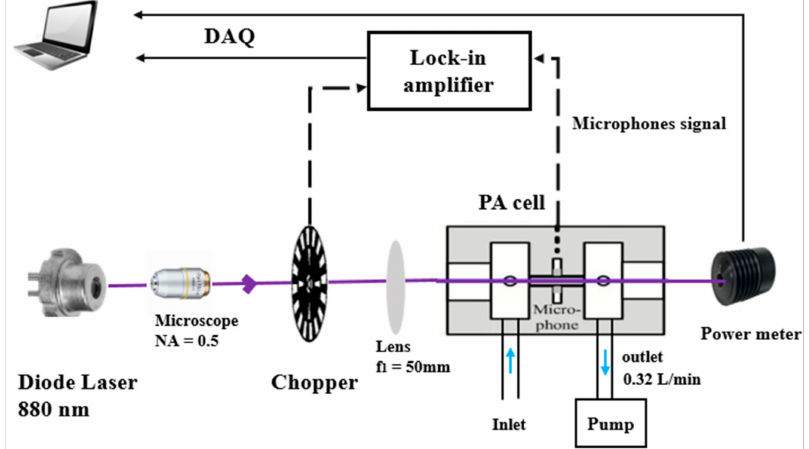
Figure 1. Schematic of the PASS instrument for BC